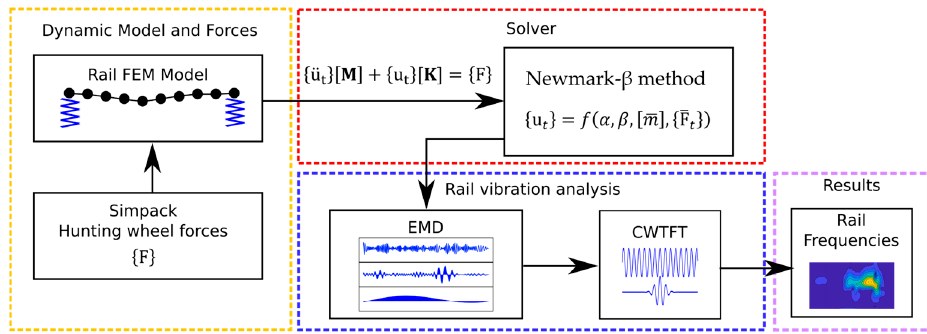
Figure 9. Flowchart for the frequency analysis of the rail response.